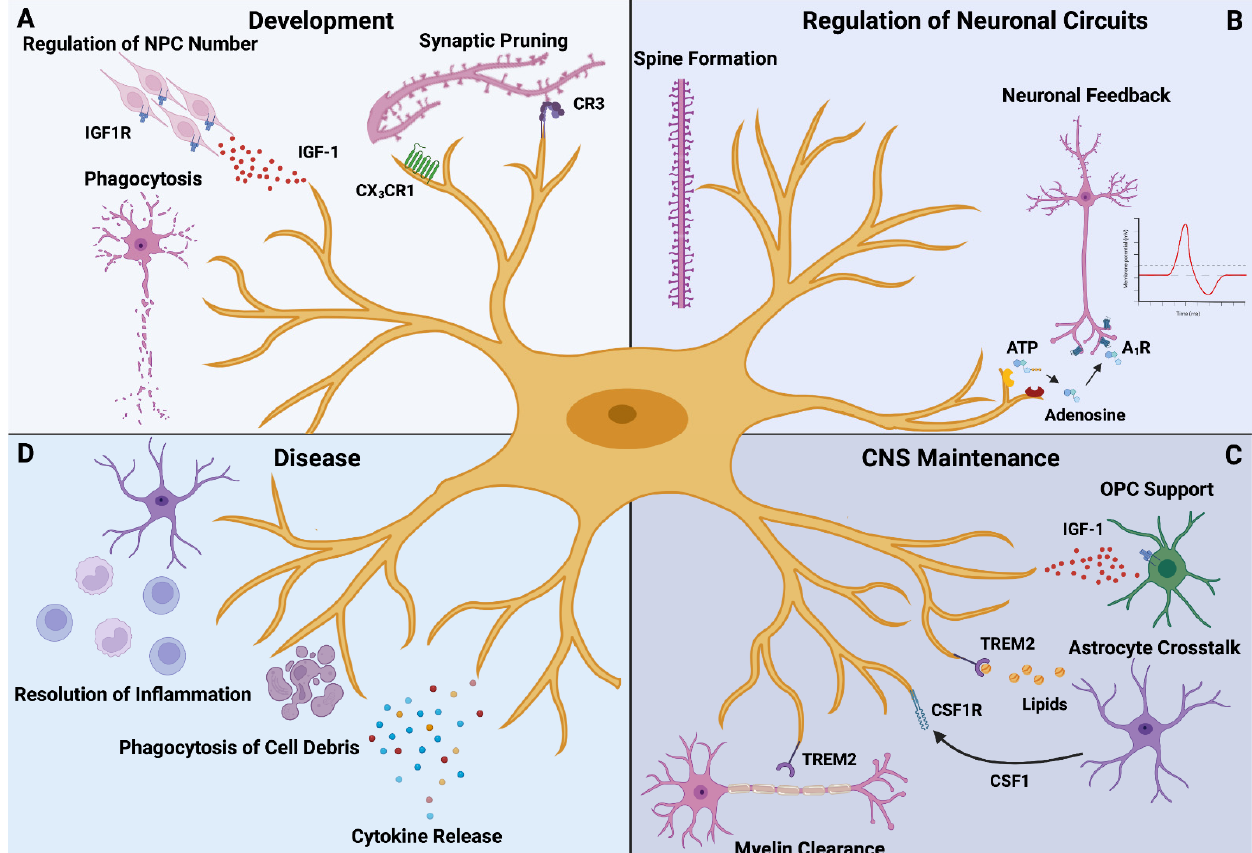
Figure 1. Functions of Microglia in Health and Disease. ( A ) During prenatal development, microglia essentially contribute to the regulation of neuronal cell numbers by removing redundant neurons through phagocytosis and regulating neuronal progenitor cell (NPC) proliferation. Moreover, they participate in the process of synaptic pruning using a plethora of receptors such as CX 3 CR1 or complement receptor 3 (CR3). ( B ) Postnatally, microglia are in intimate contact with neurons and thereby promote spine formation and form ATP-dependent negative feedback loops to tightly regulate neuronal activity. ( C ) Microglia interact with other non-neuronal cell types. They support oligodendrocyte progenitor cells (OPCs) by secreting insulin-like growth factor 1 (IGF-1) and interact with astrocytes through the CSF1–CSF1R axis and the TREM2-dependent uptake of cholesterol- containing lipids. ( D ) Under pathological conditions, microglia are key players as they are capable of secreting disease-modulating cytokines and phagocytizing cell debris. Finally, they orchestrate the resolution of inflammatory responses in the CNS through the interaction with several immune and non-immune